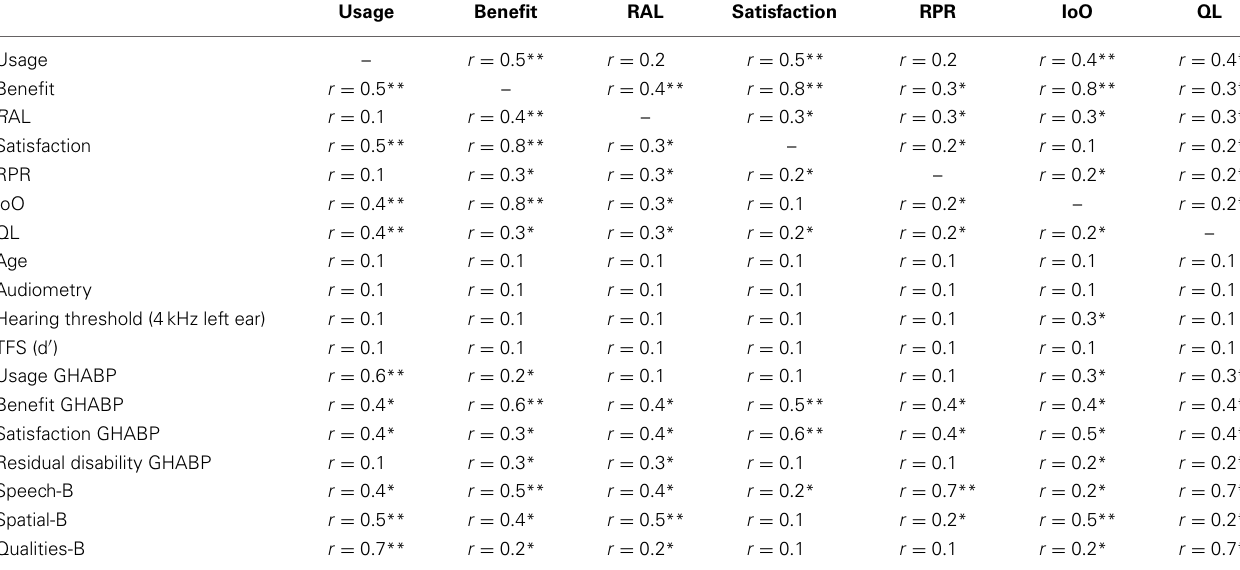
Table 5 | Results of pearson correlation for IOI-HA 3-month